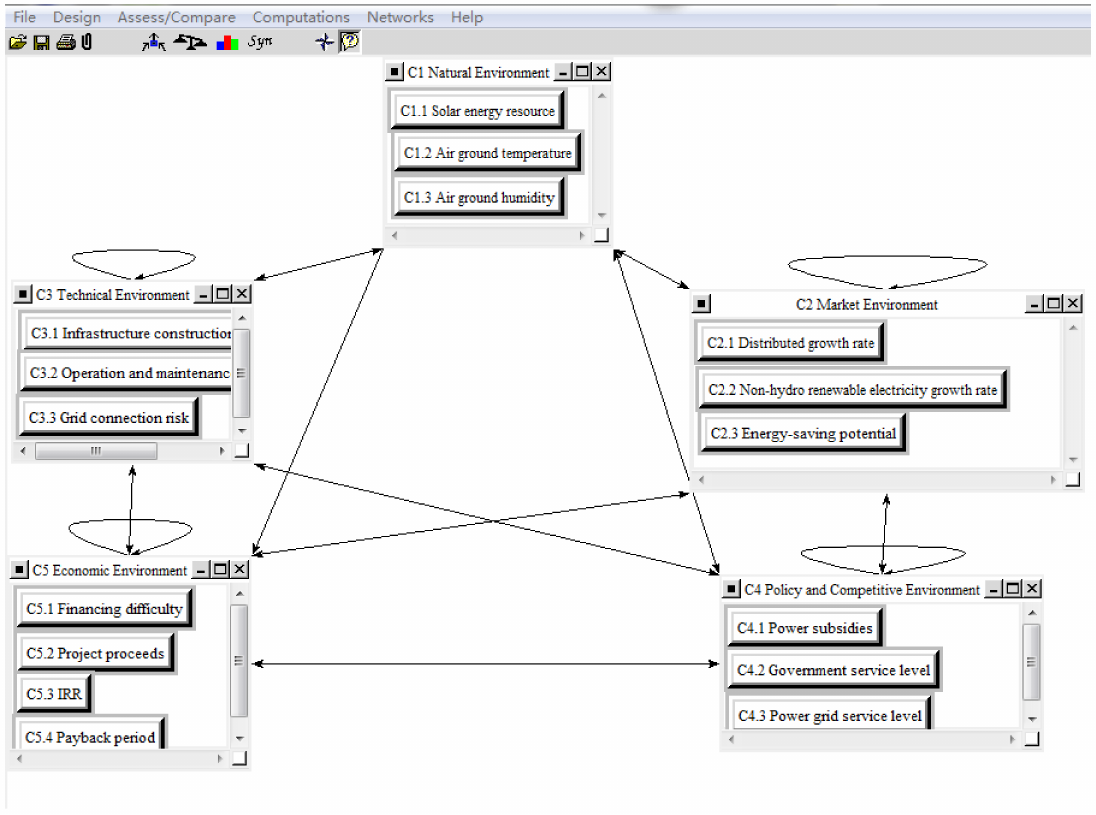
Figure A1. Using SuperDecisions to construct the relationship between